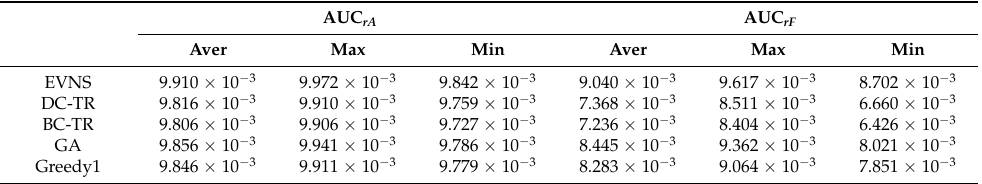
Figure 10. Comparison of different optimal recovery supplier selection methods under random disruption of 3000 suppliers: ( a ) r A recovery curves; ( b ) r F recovery curves. For a quantitative comparison of different recovery supplier selection methods, the area under the r A recovery curve (AUC rA ) and r F recovery curve (AUC rF ) for each recovery supplier selection method is calculated. Table 2 reports the average values, the maximal values, and the minimum values of AUC rA and AUC rF of 10 repeated experiments. As shown in the table, the EVNS-based method achieves the biggest value for all indicators. Such results also validate the effectiveness of the EVNS-based recovery supplier selection method. Table 2. AUC rA and AUC rF comparison of different methods under the random disruption of 3000 suppliers.